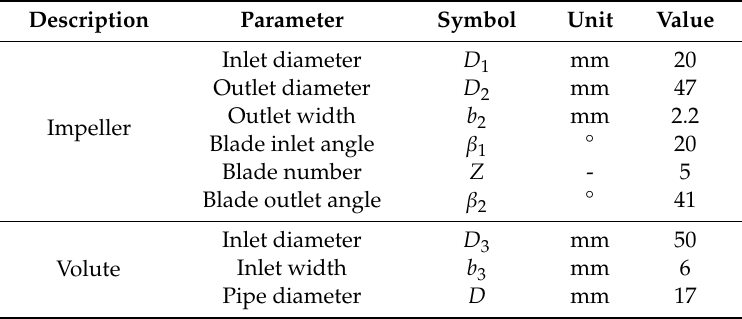
Table 1. Main geometric parameters of the